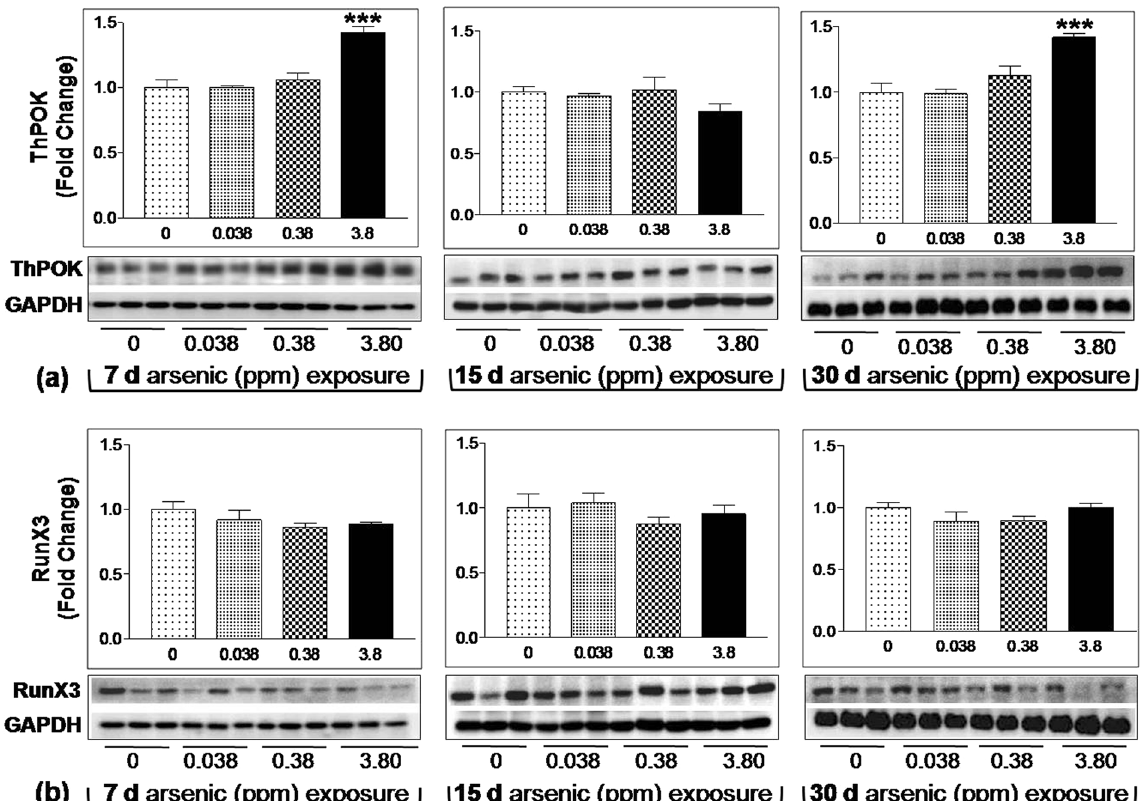
Figure 2. Effect of arsenic exposure on the expression of ThPOK and RunX3 in thymus. Thymus dissected from mice treated with arsenic (0.00, 0.038, 0.38 and 3.8 ppm) orally for 7, 15 and 30 days were homogenized for protein preparation and examined for expression of ThPOK ( a ) and RunX3 ( b ) transcription factors. Representative western blots and densitometric analysis (normalized by GAPDH) reflect significant rise in ThPOK expression following 7 and 30 days of 3.8 ppm arsenic exposure. Values represented as bar graph showing mean ± SE. (n = 3 per group) * p < 0.05, ** p < 0.01 and *** p < 0.001 compared to control. The original full-length western blots for ThPOK, RunX3 and corresponding GAPDH are provided in supplementary information sheet from Fig. S3 to Fig.